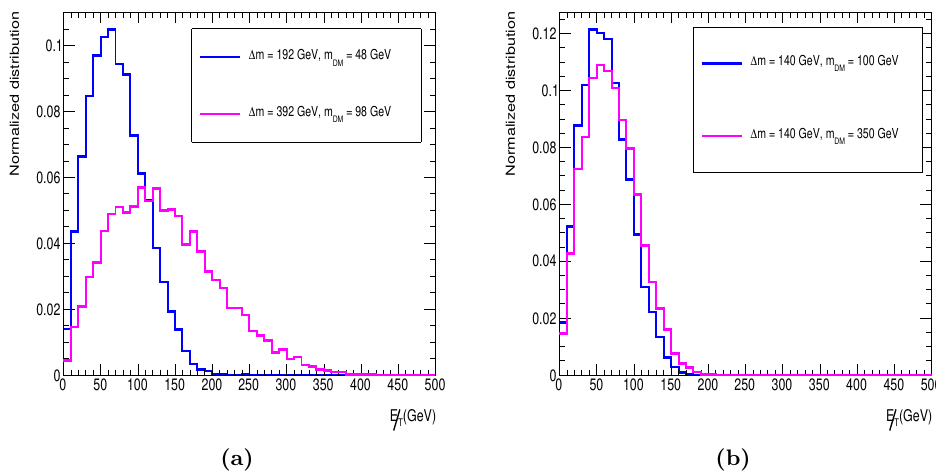
Figure 1. Normalized /E T distribution at e + e − collider with (a) fixed r , different ∆ m , and (b) with fixed ∆ m , different m (see figure insets for details). We consider pair production of the singly DM charged scalar HDSP of an inert scalar doublet, which further decays to DM in association with √ on/off shell W ± bosons at s = 500(1000) GeV, as necessary to pair produce the HDSPs